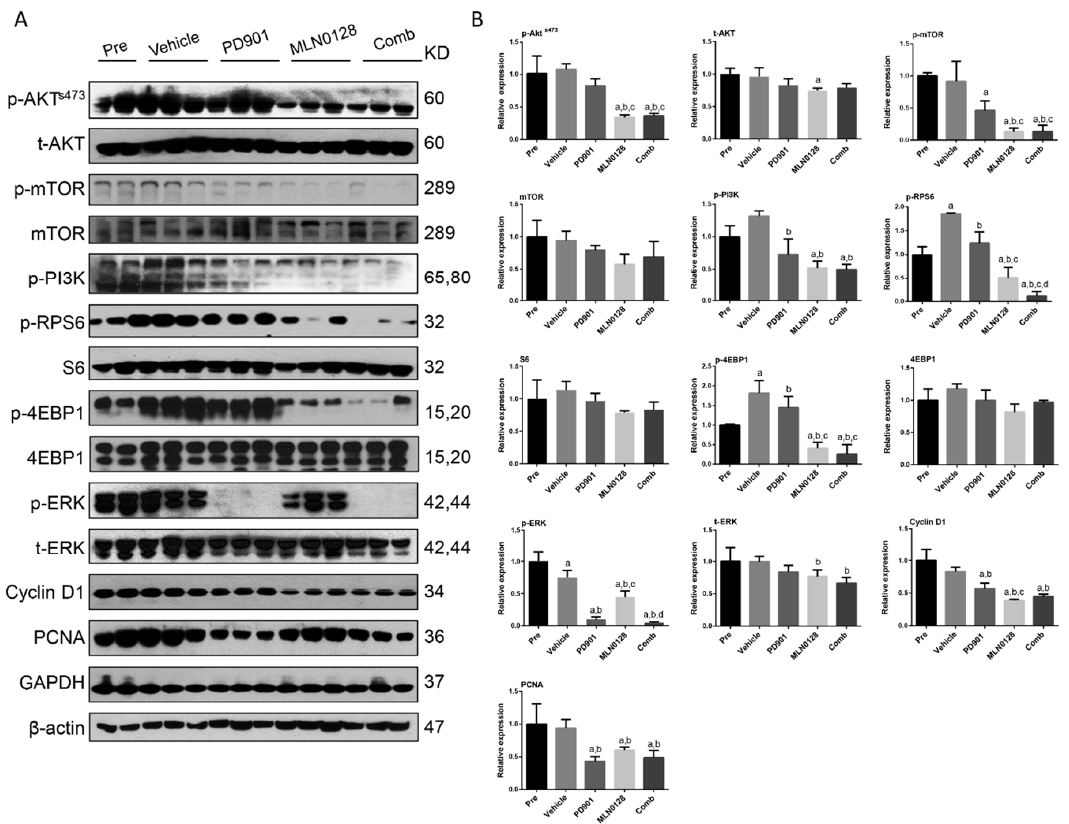
Figure 9. Effect of combined PD901/MLN0128 administration on the levels of putative target proteins in livers from AKT / c-MET mice. Western blot analysis was performed ( A ) and quantified ( B ) to analyze AKT/mTOR, Ras/MAPK, and proliferation pathways, in HCC tissues from pre-treatment, vehicle-, PD901-, MLN0128-, and PD901/MLN0128-treated AKT/c-MET mice. Western blot results were assessed by Image J software. Tukey–Kramer test: at least p < 0.01. a, vs Pre; b, vs Vehicle; c, vs PD901; d, vs MLN0128; e, vs Comb. Abbreviations: Pre, Pre-treatment; Comb, combined PD901/MLN0128 treatment.